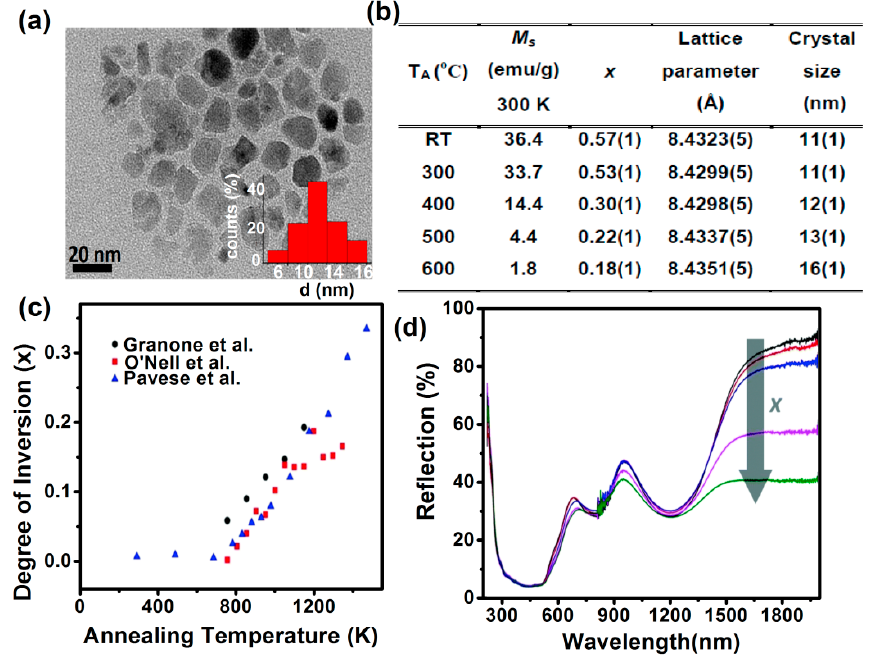
Figure 5. ( a ) Low-magnification TEM image of ZnFe 2 O 4 nanoparticles of average size 11 nm. ( b ) Cation inversion and lattice parameter, Ms and crystalize at different annealing temperatures (Reproduced with permission from [40]. Copyright American Chemical Society, 2019). ( c ) Degree of inversion, x , versus the annealing temperature comparison of result with values obtained by different groups (Reproduced with permission from [42]. Copyright PCCP Owner Societies, 2018). ( d ) UV-diffuse reflectance spectrum of ZnFe 2 O 4 nanoparticles with increasing degree of inversion (— x = 0.074; x = 0.104; x = 0.134; x = 0.159; x = 0.203).